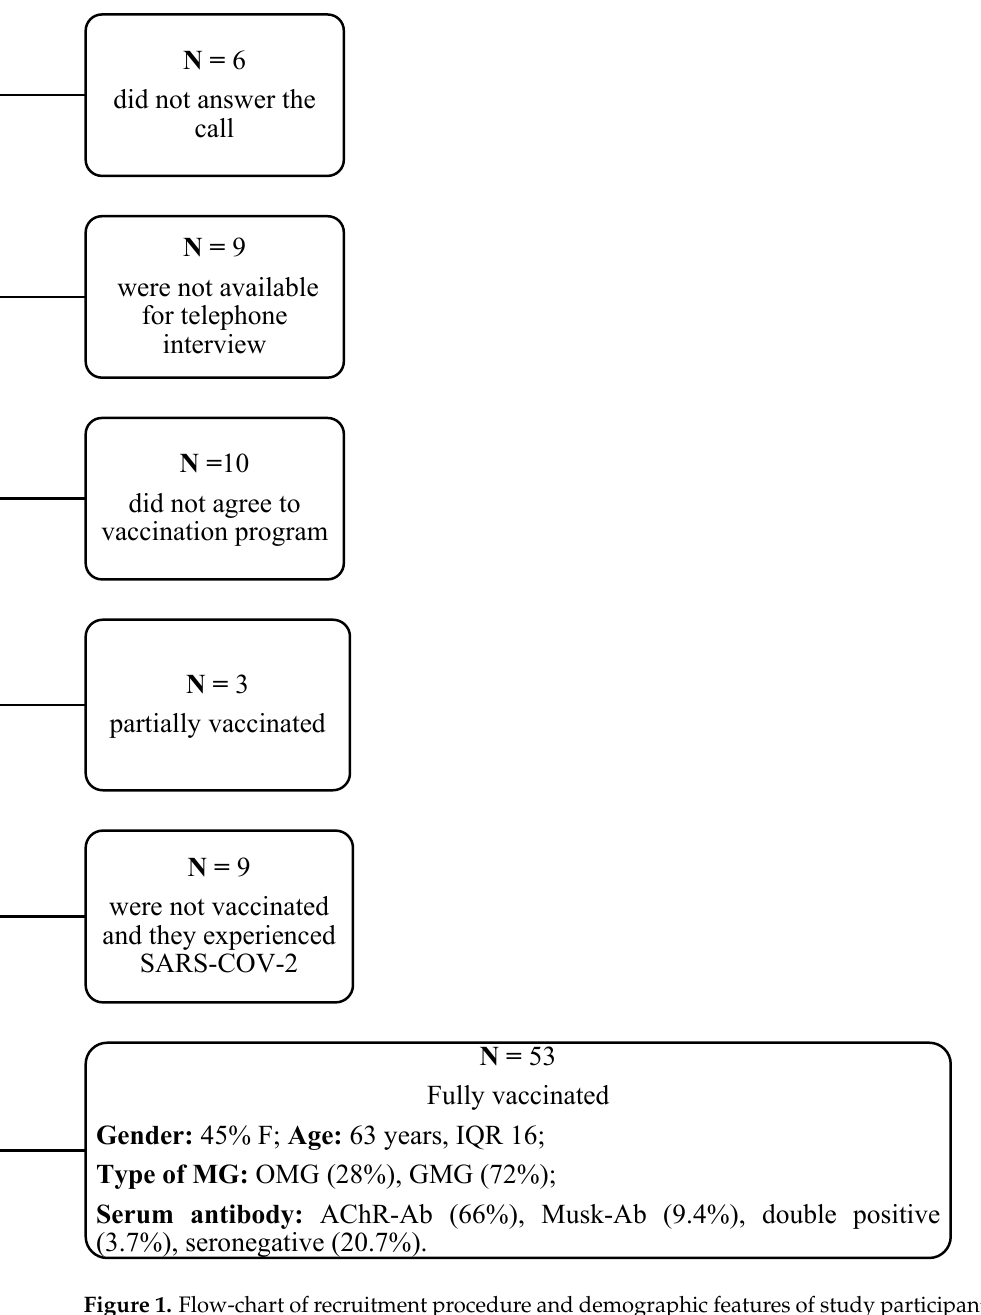
Figure 1. Flow-chart of recruitment procedure and demographic features of study participants. OMG, Ocular Myasthenia Gravis; GMG, Generalized Myasthenia Gravis; F, female; AchR-ab, acetylcholine receptors; MuSK-Ab, muscle-specific kinase. Fifteen patients (16.5%) were excluded from the analyses because they did not an- swer the questionnaire; therefore, 75 patients were in the final study sample. Thirteen